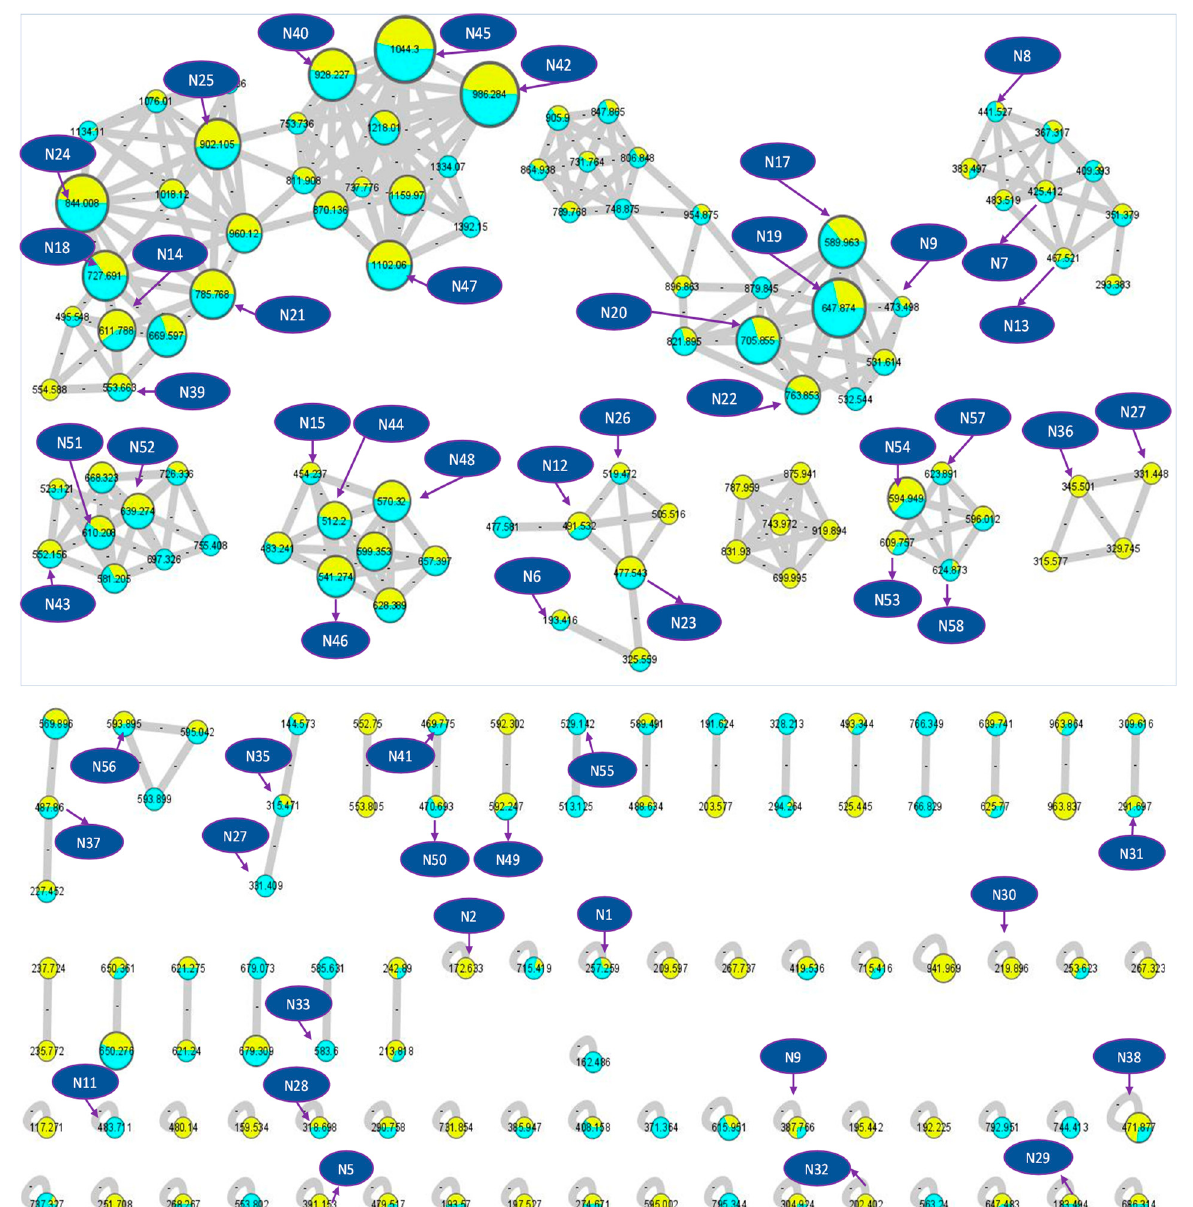
Figure 2. Molecular network (showing clusters of metabolites of interest) based on tandem mass spectrometry data in the positive ionization mode of Lantana extracts. The network is displayed as a pie chart to reflect the relative abundance of each ion in the analyzed samples. L. camara is indicated in yellow and L. montevidensis is indicated in light blue.